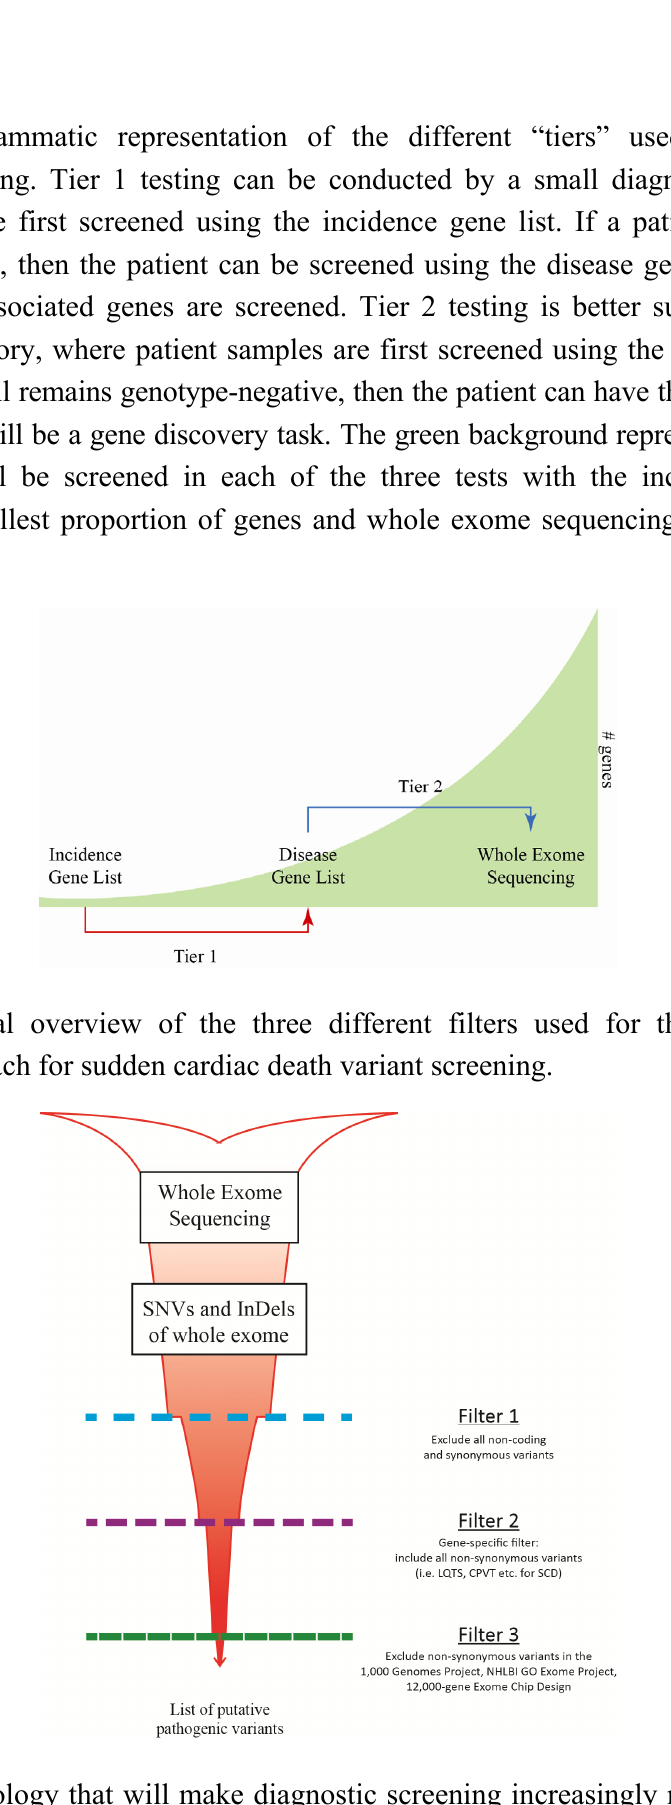
Figure 5. Diagrammatic representation of the different “tiers” used for molecular